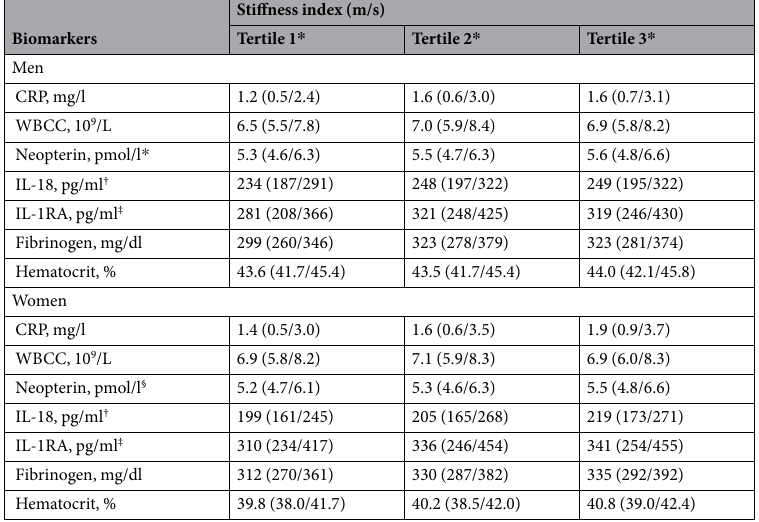
Table 2. Biomarker Distribution According to Tertiles of Stiffness Index (n = 12,650). Data are expressed as medians (1 st /3 rd quartile). P trend for all biomarkers < 0.0001, except WBCC in females with P trend = 0.062. * Tertile cut-points for SI were 6.91 m/s and 9.37 m/s in men, and 5.58 m/s and 7.25 m/s in women. § n = 3,548 (1,886 men/1,662 women); † n = 4,078 (2,245 men/1,833 women); ‡ n = 4,442 (2,337 men/2,105 women). CRP stands for C-reactive protein, WBCC for white blood cell count, IL-18 for interleukin-18, and IL-1RA for interleukin-1 receptor antagonist.